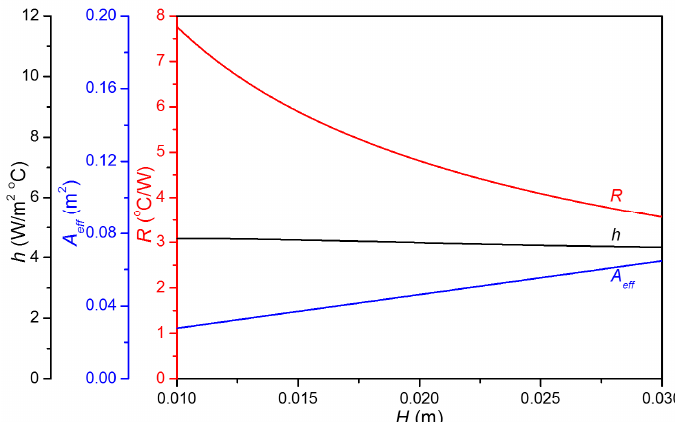
Figure 10. Effects of fin number on effective surface area, heat transfer coefficient, and thermal resistance.